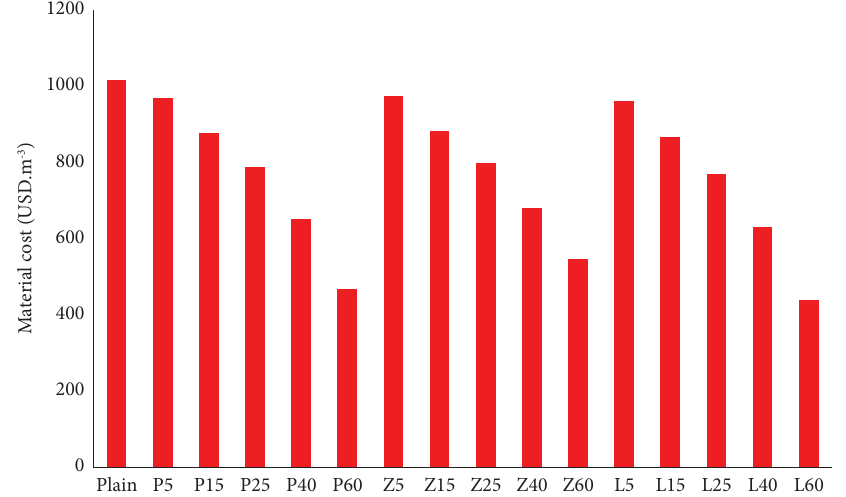
Figure 17: Te total cost of mixtures per cubic meter